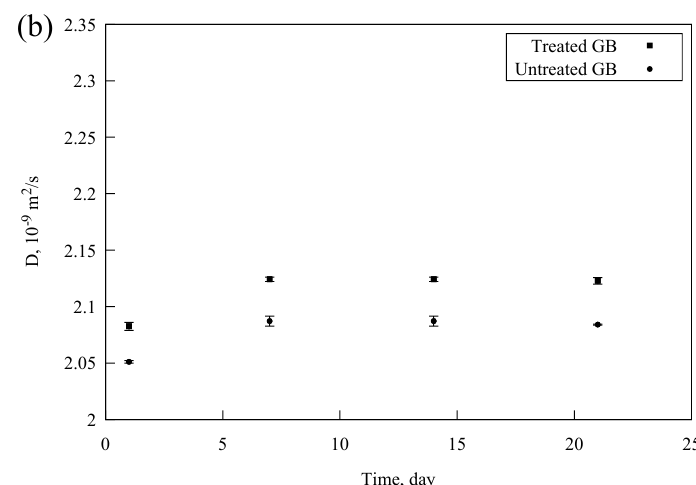
Figure 9. Diffusion coefficient behavior of treated and untreated glass beads for different aging times and at 25 ◦ C: ( a ) 1% Na 2 SO 4 ; ( b ) 100% Na 2 SO 4